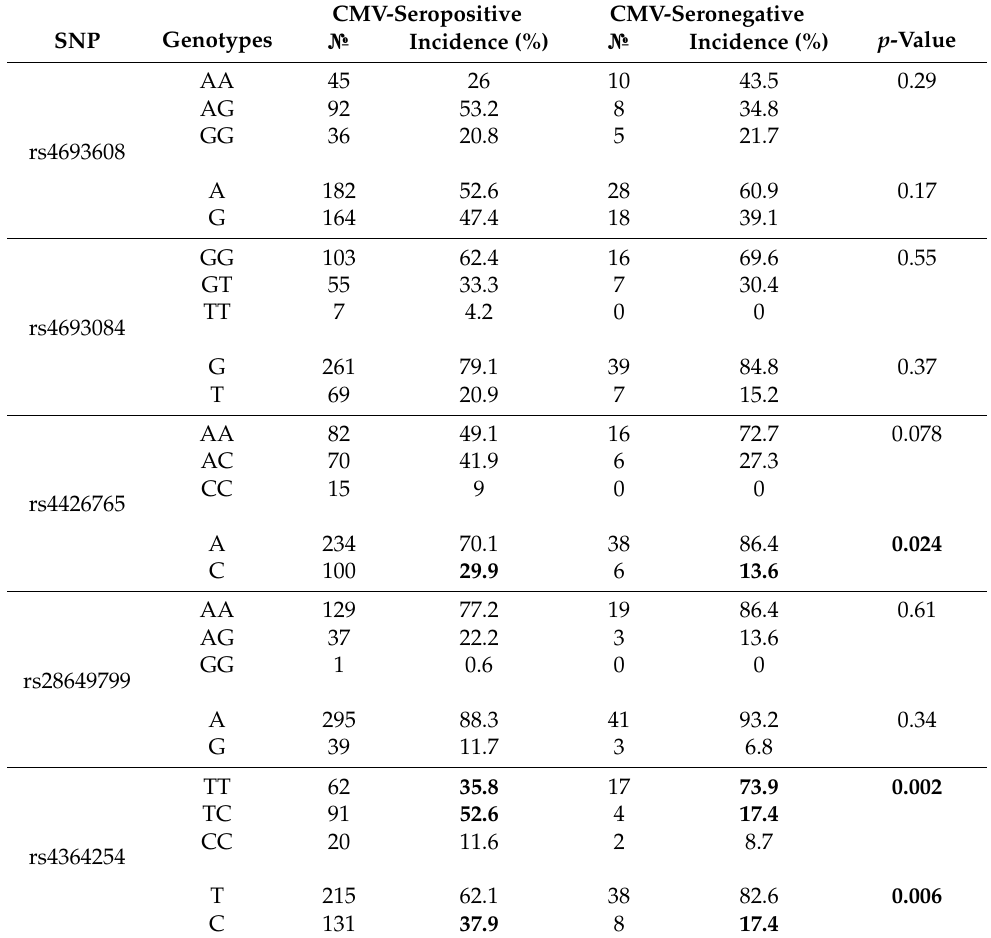
Table 3. Genotype and allele frequencies of the HPSE gene SNPs in CMV seropositive and seronega- tive AML patients.